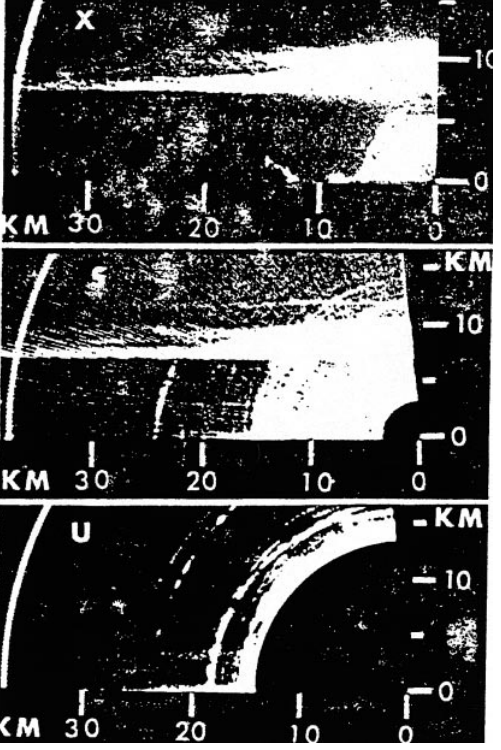
Fig. 1. RHI (range-height-intensity) scans at 3.2 cm (X band), 10.7 cm (S band), and 71.5 cm (UHF band) wavelengths ( top , center , and bottom panels , respectively) at 90 (cid:176) azimuth taken at 1030 EST 18 February 1966 at Wallops Island, Virginia. The layer at 12 km in the bottom panel was visible on the original photographs (from Atlas et al ., 1966b)